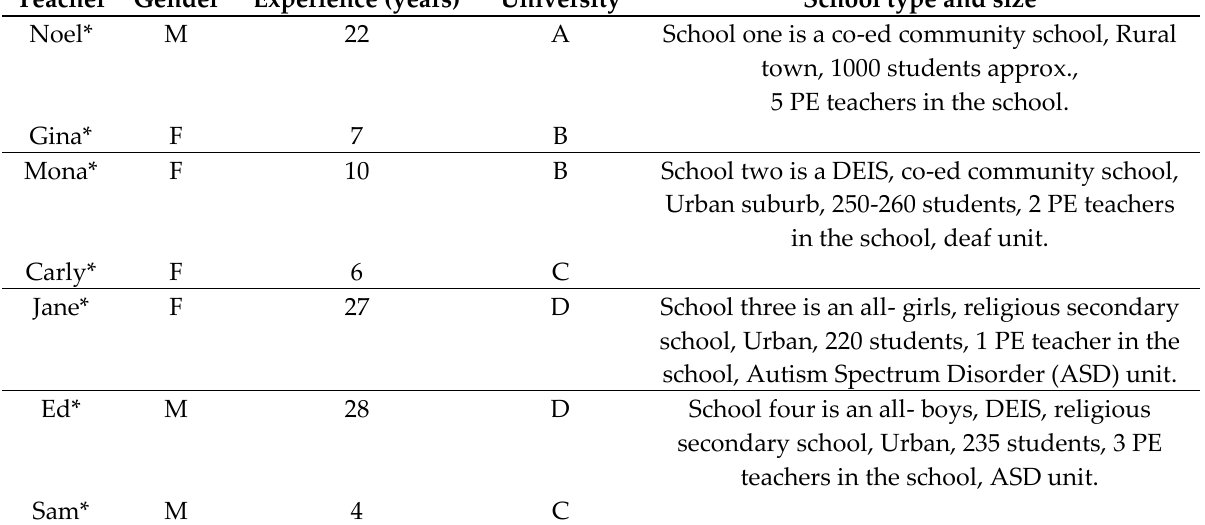
Table 1 . Background data of PE teachers and school